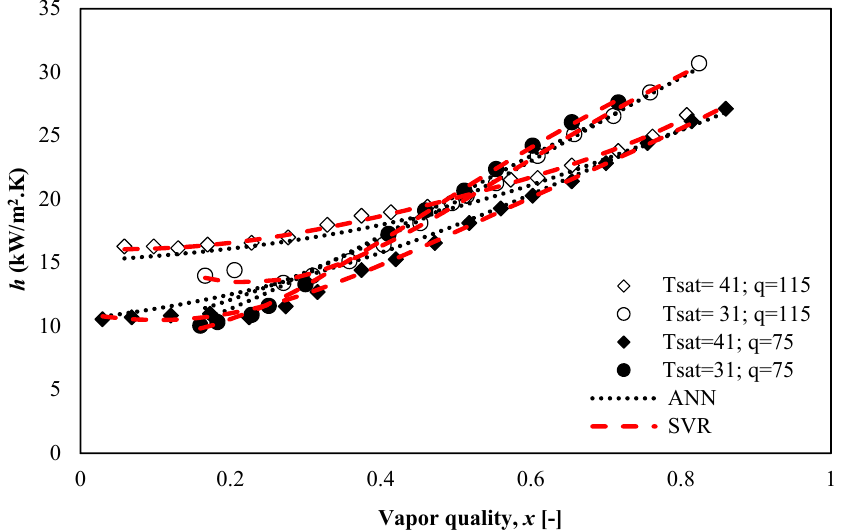
Figure 9. Observed and modeled heat transfer coefficient for R600a in a mini-channel at two different saturation temperatures in °C ( q = 115 kW/m 2 and 75 kW/m 2 ; G = 500 kg/m 2 ·s).